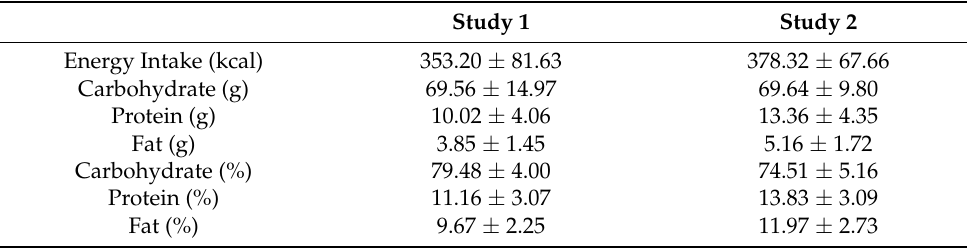
Table 2. Macronutrient content and energy intake of breakfast in the two